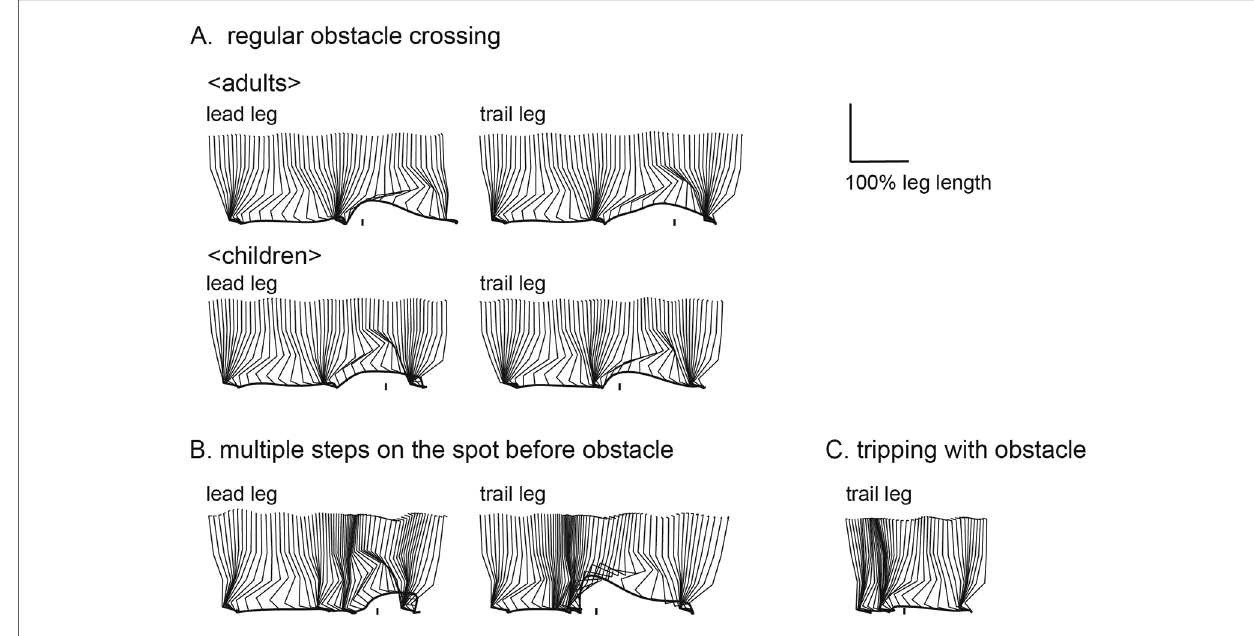
FIGURE 4 Examples of sagittal stick pictures normalized to leg length during obstacle crossing. Most children aged 2 – 5 years were able to clear an obstacle set to a height of 10% of leg length as well as adults [( A ), top: adult, 20 years old; bottom: child, 5.7 years old]. Children varied in obstacle-crossing behavior, with one taking several steps on the spot before crossing an obstacle [( B ): child, 2.4 years old] and one bringing the trail leg into contact with the obstacle [( C ): child, 2.9 years old].